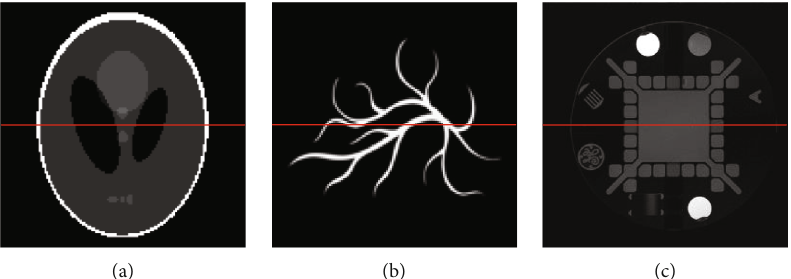
Figure 1: The (a) Sheep-Logan phantom, (b) blood vessel phantom, and (c) standard General Electric resolution phantom employed in the 2D computer-simulation